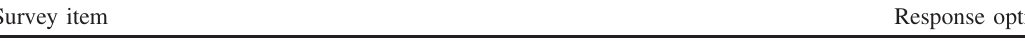
TABLE II. The physics self-efficacy survey. One item indicated with an ( R ) is reverse coded. Survey